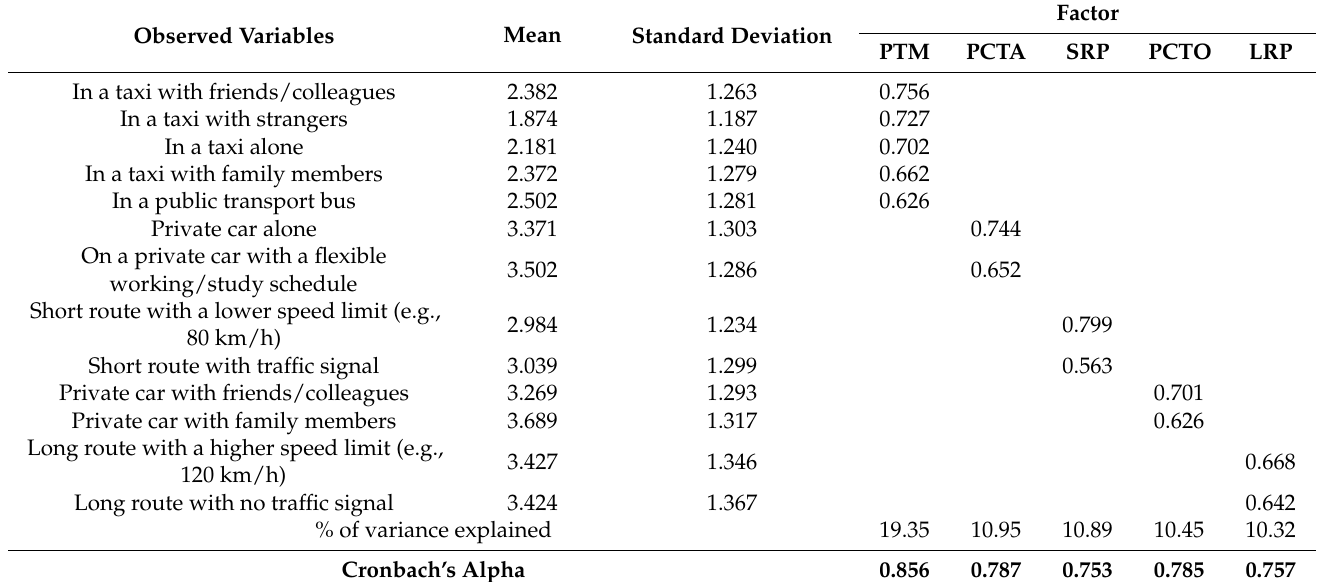
Table 4. Rotated factor loadings of travel interests with travel time saving